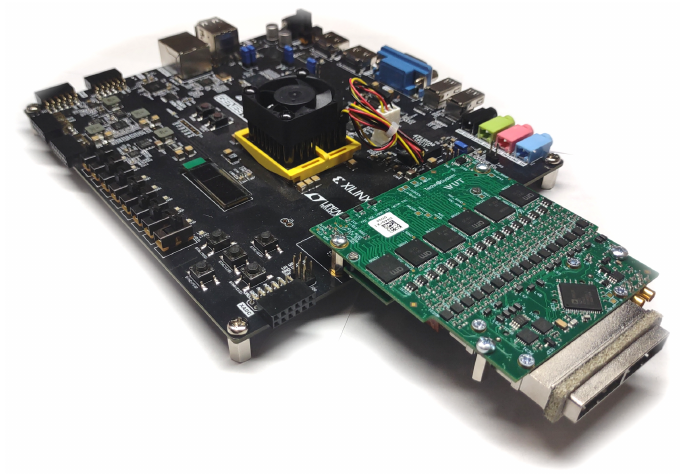
Figure 29. Minimal MCORD DAQ testing setup using FMC ADC100M 10B TDC 16cha and Digilent Genesys